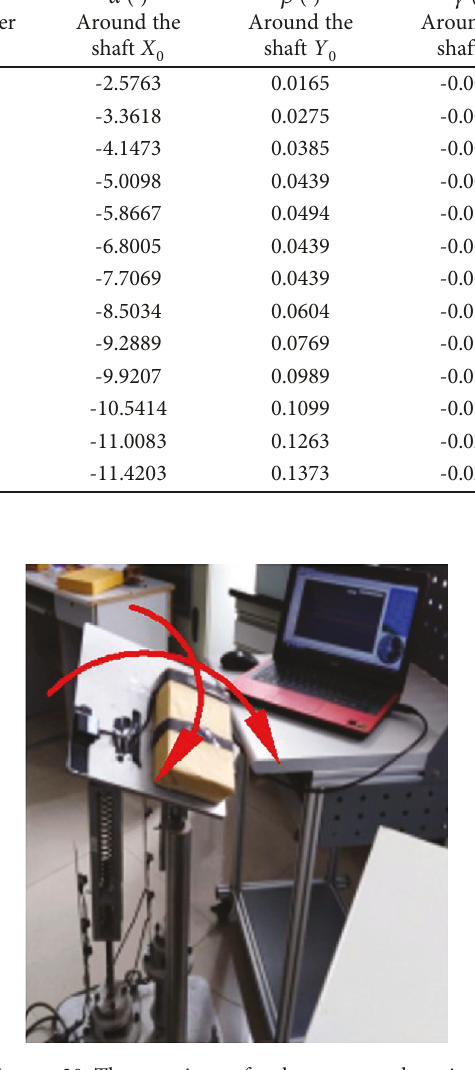
Figure 20: The experiment for the compound